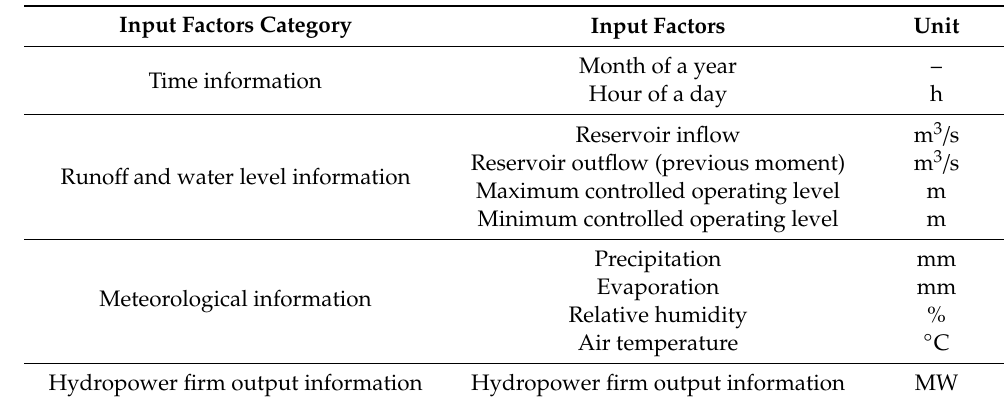
Table 1. Details of the model input